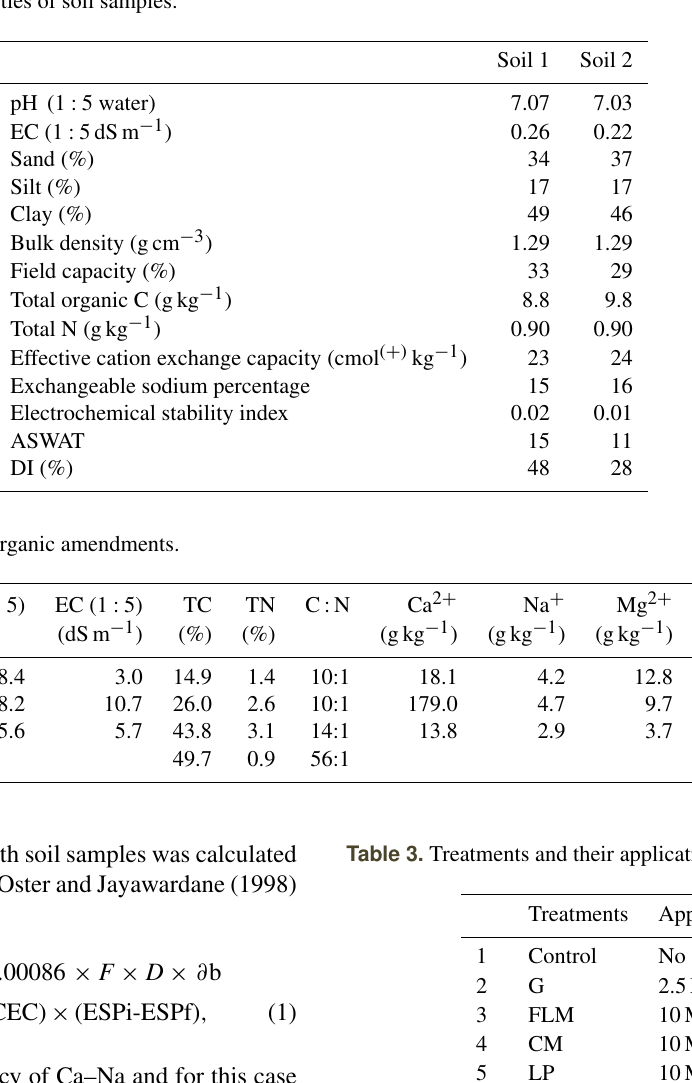
Table 1. Physico-chemical properties of soil samples.